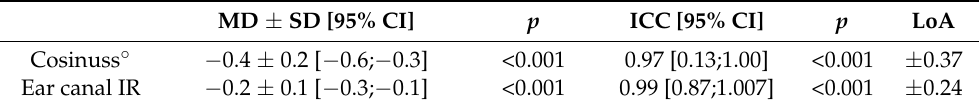
Table 1. Cosinuss ◦ and IR thermometer versus mercury thermometer using the paired t-test with mean difference (MD) with standard deviation (SD) and the intraclass correlation coefficient (ICC) with a confidence interval of 95%, p -value and limits of agreement